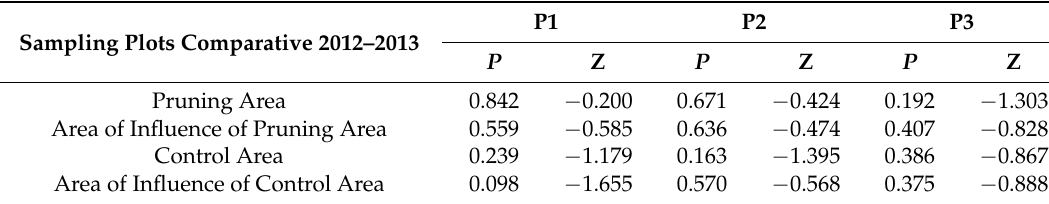
Table 4. Statistical comparison of the Population Intensity recorded in 2012 with respect to those of 2013 in the whole of the areas sampled at each sampling plot (P1, P2, and P3). Z = Value of the statistic for the Mann-Whitney U test; P = Probability ( α ≤ 0.05).